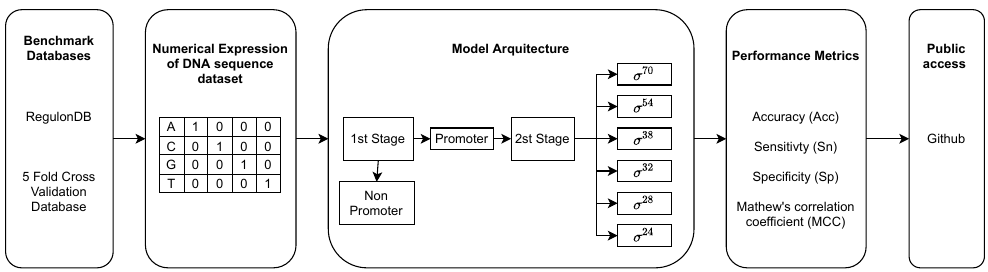
Figure 2. Overview of the PromoterLCNN model.